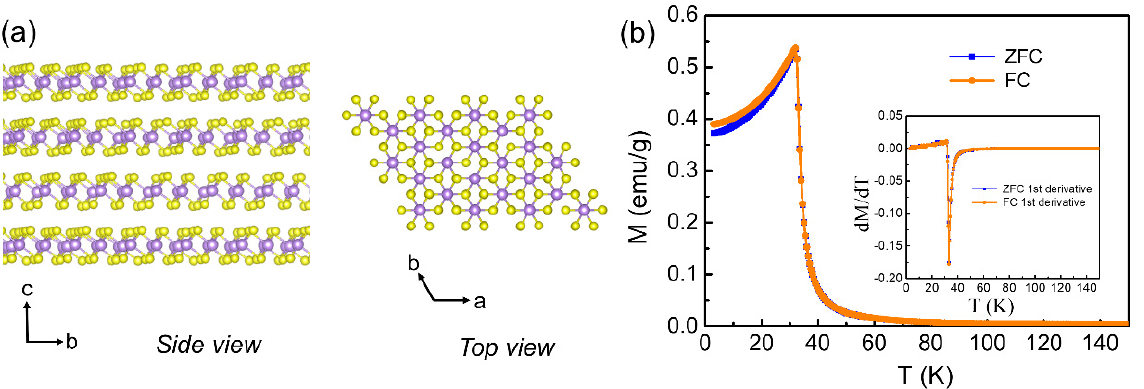
Figure 1. ( a ) Crystal structure of CrBr 3 below the Curie temperature. Left: side view of bc plane. Right: top view of the ab plane. The colored balls represent Cr (purple) and Br (yellow), respectively. ( b ) Temperature dependence of ZFC and FC magnetization for a CrBr 3 platelet under an in-plane magnetic field of 50 mT. Inset: the first-order temperature derivatives of ZFC and FC magnetization. The chemical composition of CrBr 3 flakes on SiO 2 /Si substrates was analyzed by